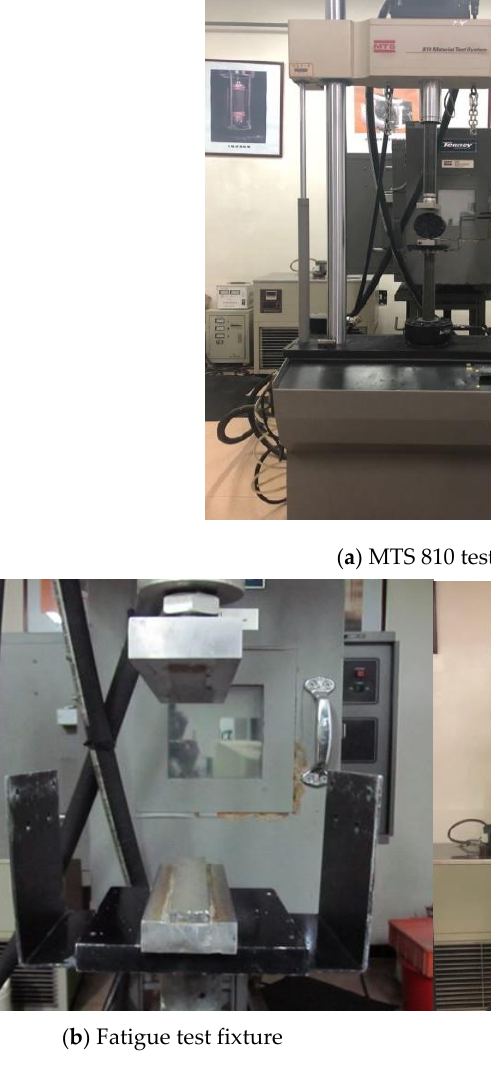
Figure 7. Photographs of the fatigue test equipment.